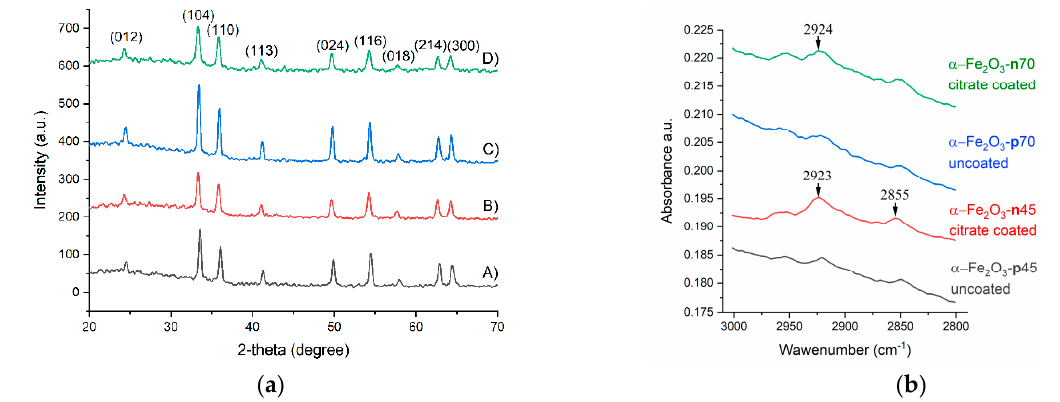
Figure 1. ( a ) XRD patterns of α -Fe 2 O 3 nanoparticles (NPs): (A) α -Fe 2 O 3 - p 45, (B) α -Fe 2 O 3 - p 70, (C) α -Fe 2 O 3 - n 45, (D) α -Fe 2 O 3 - n 70. The peak positions of the pure rhombohedral phase of α -Fe 2 O 3 (ICDD 98-000-0240). ( b ) Attenuated total reflection–Fourier transform infrared (ATR-FTIR) spectra of α -Fe 2 O 3 NPs before and after citrate coating.